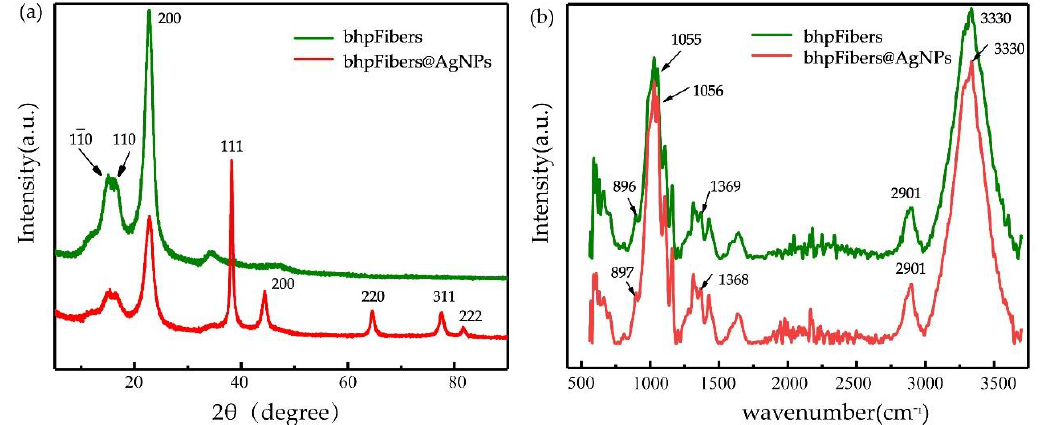
Figure 2. XRD patterns ( a ) and FT-IR spectra ( b ) of bhpFibers and bhpFibers@AgNP-based paper.